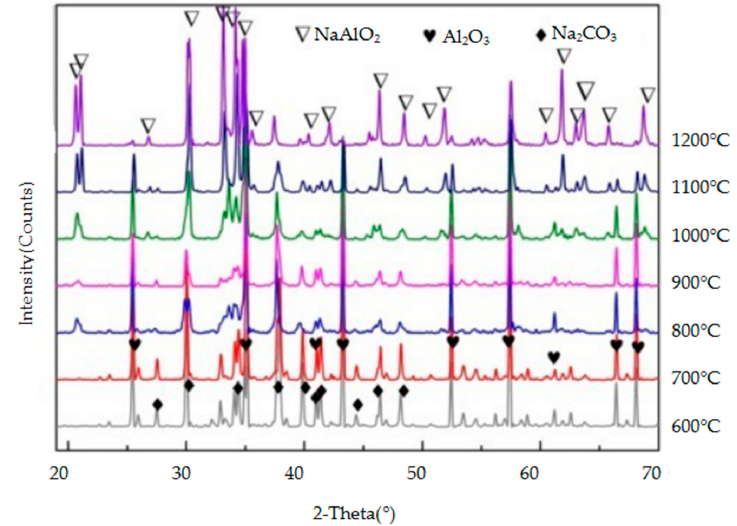
Materials 2018 , 11 , x FOR PEER REVIEW Figure 9. X-ray diffraction (XRD) patterns of the products of the reaction between Al 2 O 3 and Na 2 CO 3 .